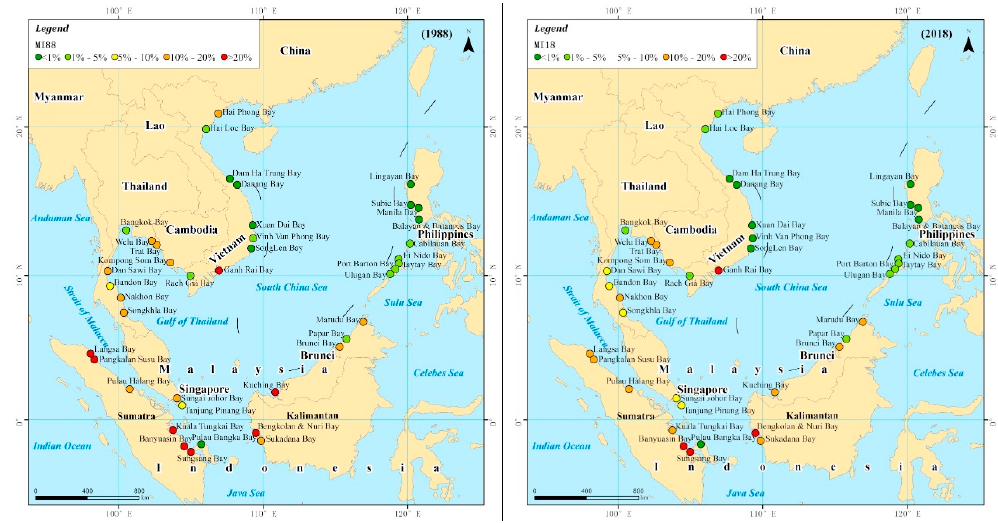
Figure 10. MI of the bays in 1988 and 2018.